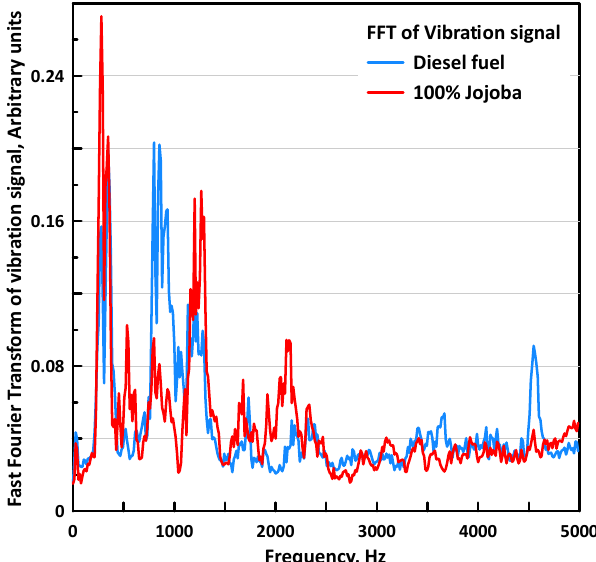
Figure 17. FFT of vibration signal for the two fuels at N = 1950 rpms.